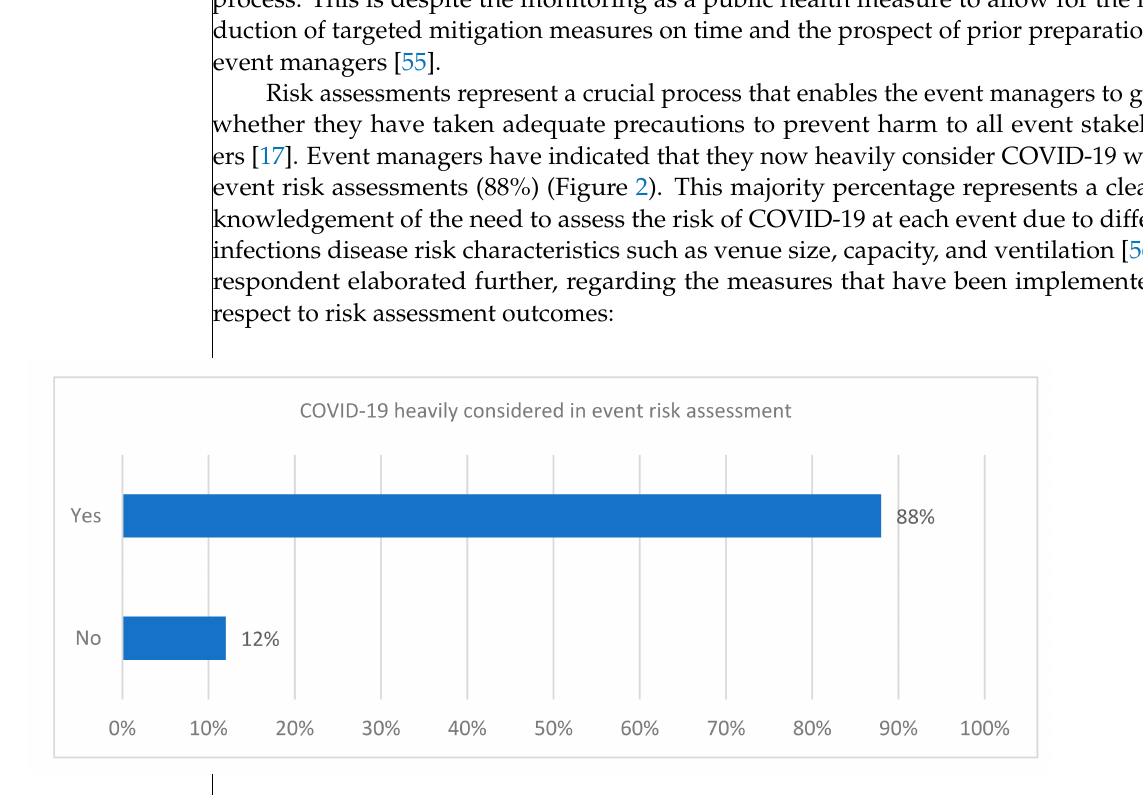
Figure 2. Consideration of COVID-19 in event risk assessment ( n =